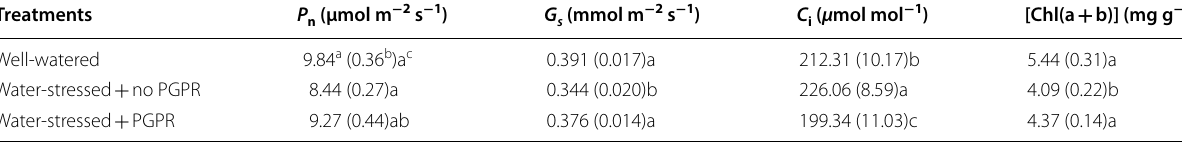
a Data are the means of three repeating groups (twelve seedlings for each repeat group) b Numbers are standard deviations c Different letters indicate significant differences among treatments at P < 0.05 by LSD